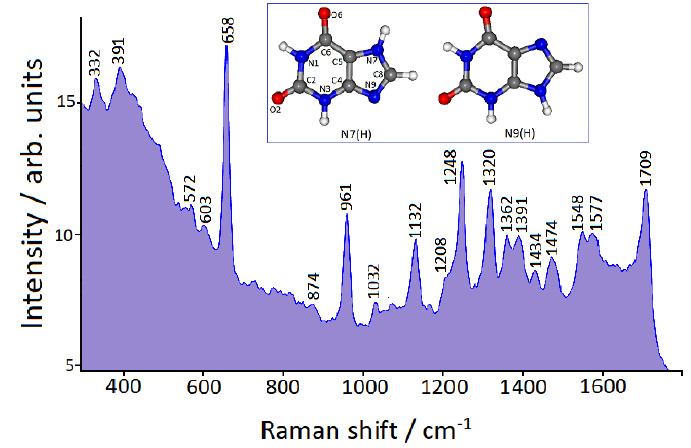
Figure 4. Fourier transform-surface-enhanced Raman scattering (FT-SERS) spectrum of 10 − 6 M xanthine in Au colloid (1064 nm exciting line). The tautomeric forms of xanthine are shown in the inset.